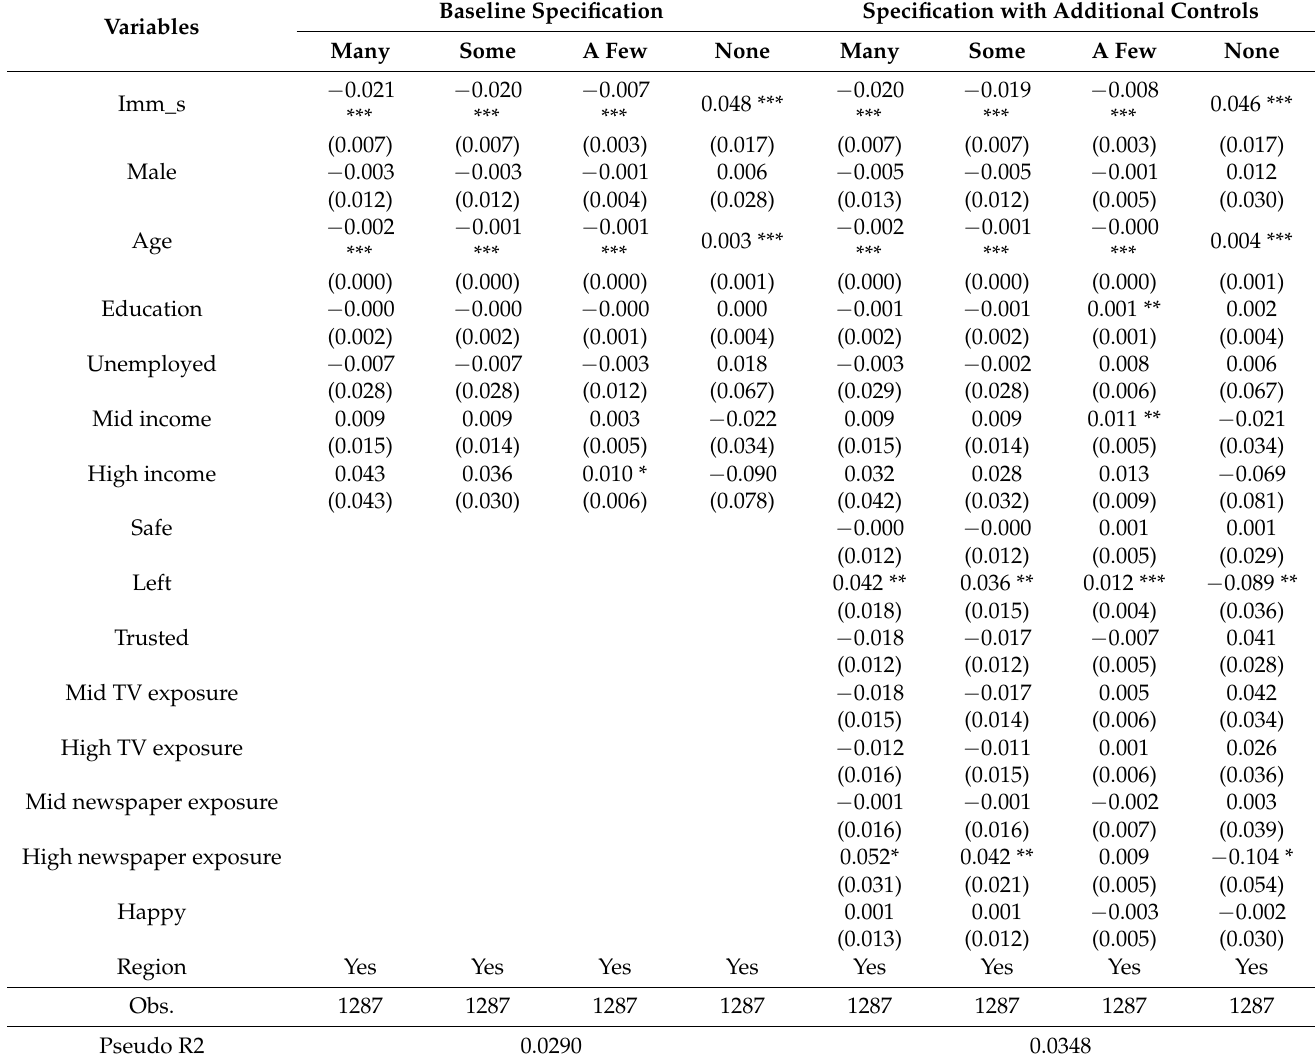
Table 5. Should Turkey allow people from the poorer countries outside